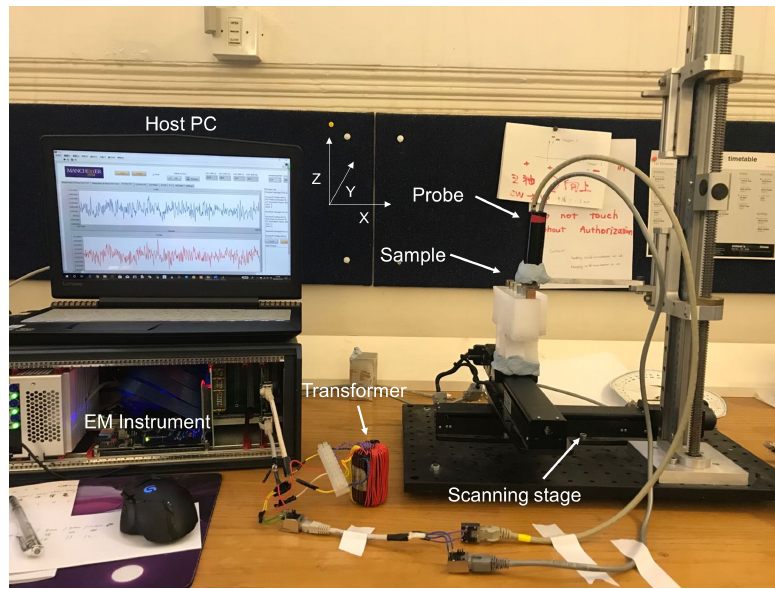
Figure 2. Photo of the entire separation